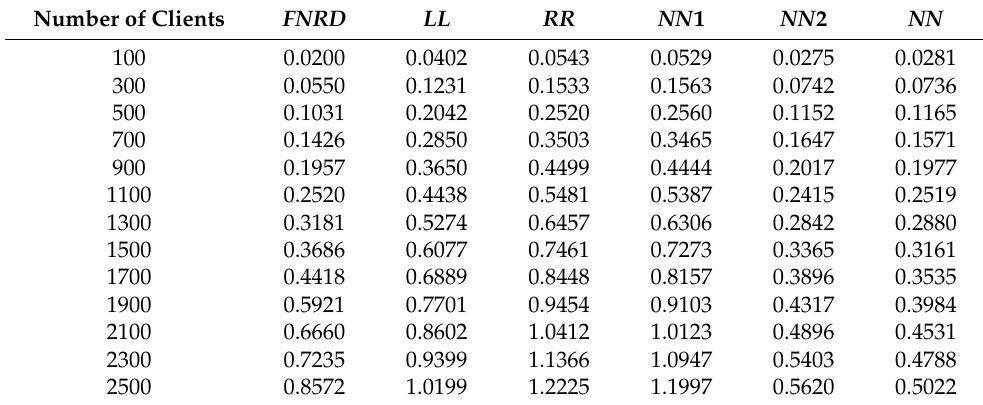
Table 1. Results of the comparison of mean response time in tabular form.